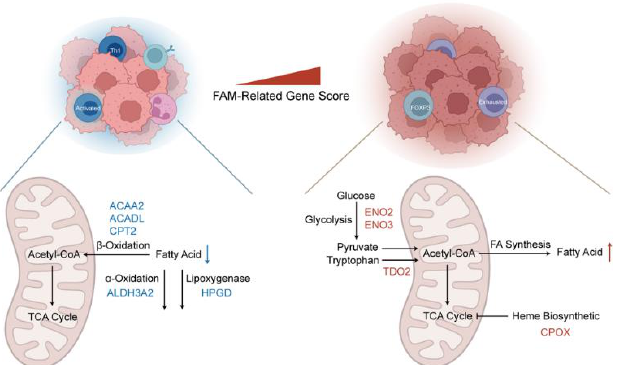
Figure 5. Diagram of the underlying FAM mechanisms for ccRCC. FAM: Fatty acid metabolism; ccRCC: Clear Cell Renal Cell Carcinoma. The blue arrow represents the decrease of fatty acid synthesis, and the red arrow represents the increase in fatty acid synthesis. The black arrow represents the pathway of fatty acid synthesis and decomposition.